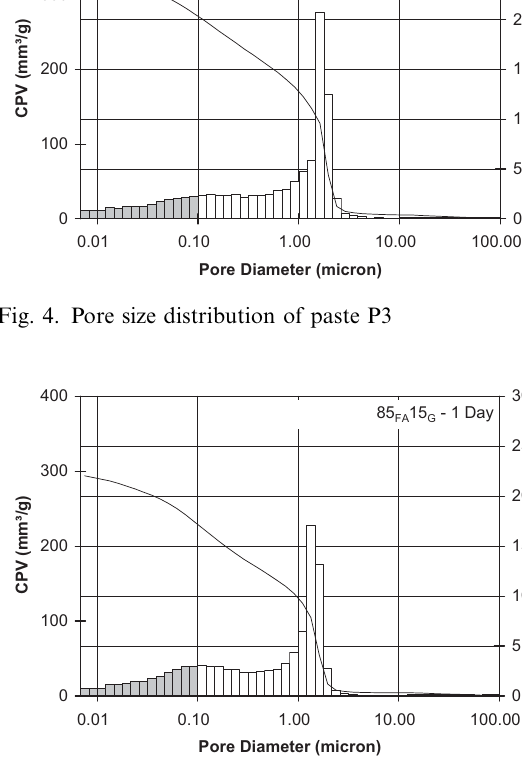
Fig. 5. Pore size distribution of paste